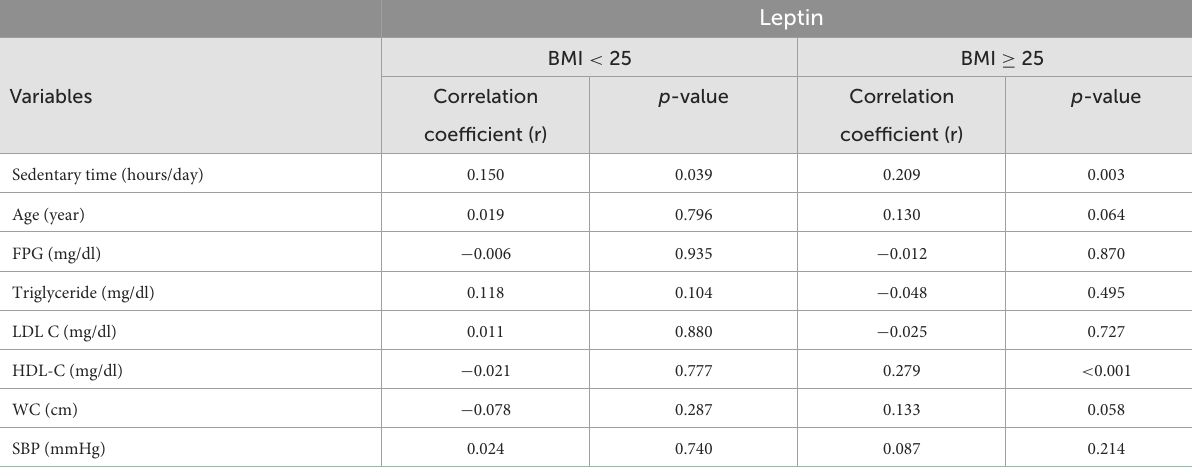
TABLE 2 Spearman’s correlation analysis with plasma leptin level as the dependent variable in different BMI group.